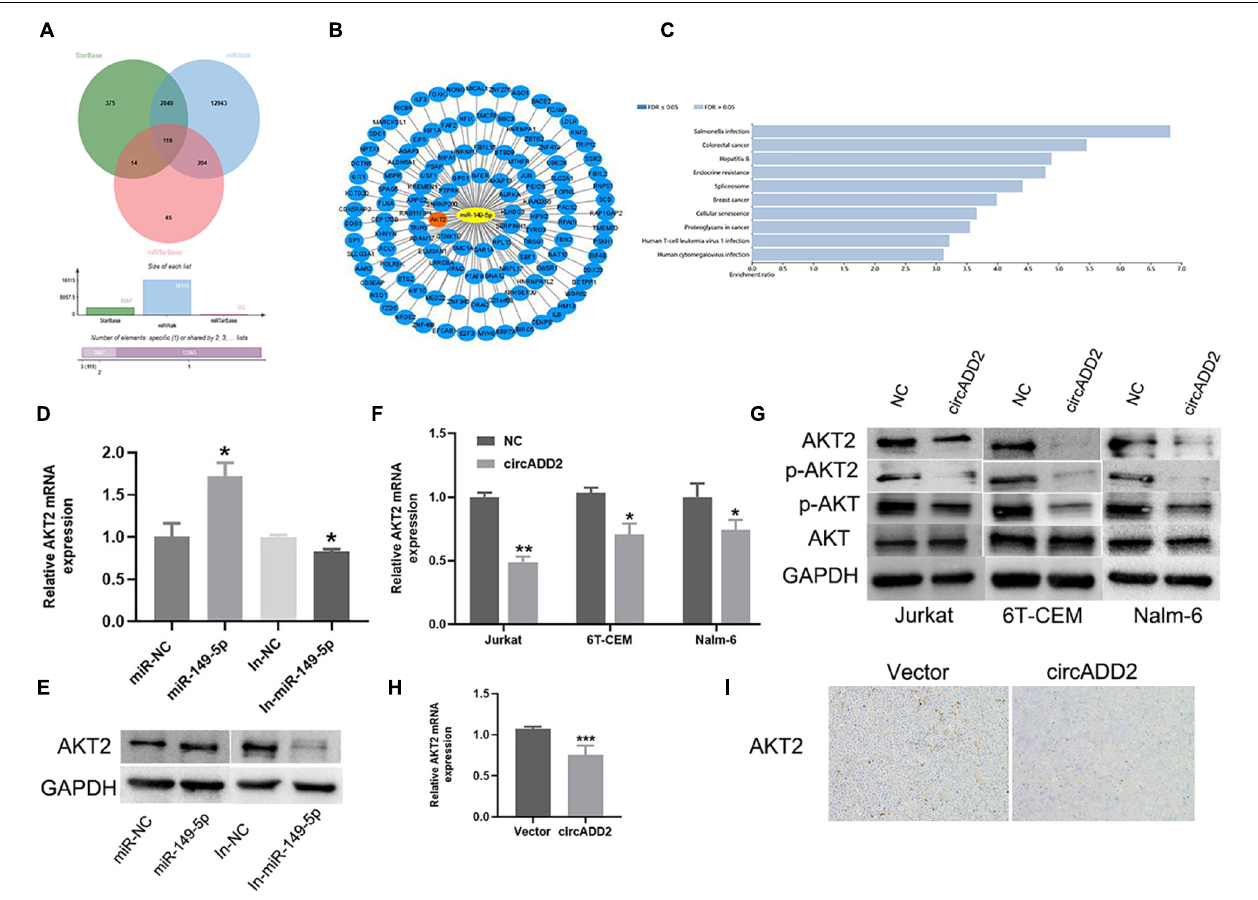
FIGURE 6 | Overexpression of circADD2 reduced the expression of AKT2. (A) The Venn plots showed downstream genes binding to miR-149-5p. (B) Cytoscape graphs of miR-149-5p and target genes . (C) KEGG enriched the signal pathways of miR-149-5p target genes. (D,E) Jurkat cells transfected with miR-149-5p mimics or miR-149-5p inhibitor. The level of AKT2 was detected by qRT-PCR and western blot. The results showed that miR-149-5p increased AKT2 expression, while inhibition of miR-149-5p decreased AKT2 expression. (F,G) Relative expression of AKT2 was detected by qRT-PCR and Western blot in ALL cells transfected with circADD2. We found that after overexpression of circADD2, the level of AKT2 and its phosphorylation decreased. (H) AKT2 levels were detected by qRT-PCR in tumor cells from xenograft generated by Jurkat cells stably transfected with circADD2 or control vector. AKT2 level was significantly decreased after circADD2 overexpression in vivo . (I) IHC staining was used to detect the expression of AKT2 in the xenografts, and the level of AKT2 in the circADD2 groups was significantly reduced. Data were showed as mean ± SD and analyzed by unpaired t -test, * P < 0.05, ** P < 0.01, *** P <